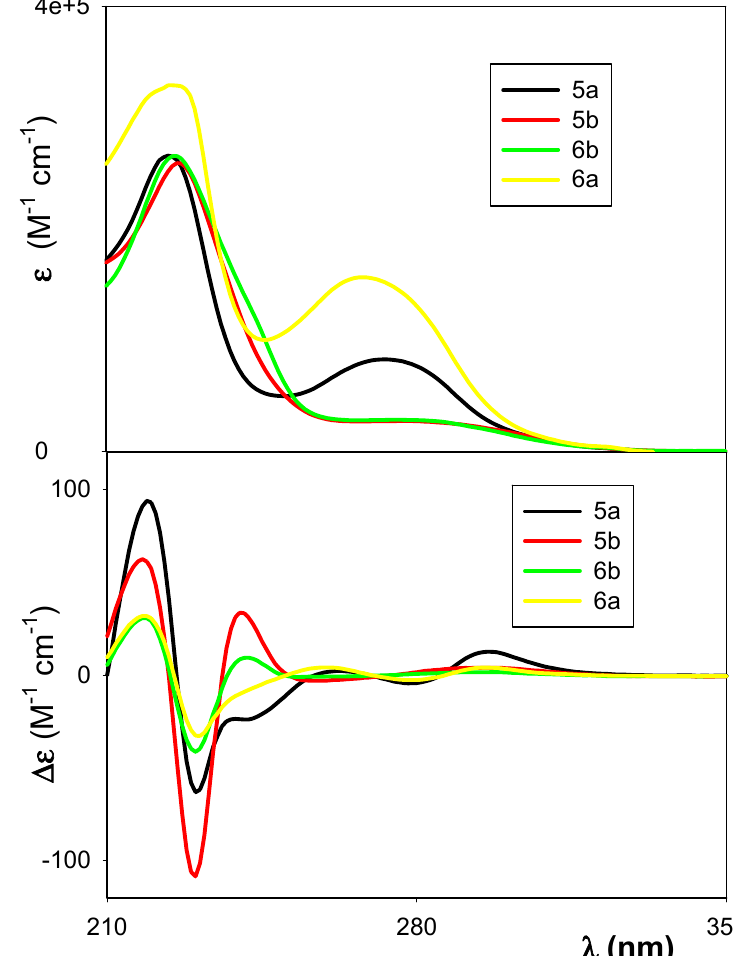
λ (nm) Figure 2. UV ( top ) and circular dichroism (CD) ( bottom ) spectra of macrocycles 5 and 6 . Concentrations: 10 − 5 M for UV and 2.2–2.6 10 − 6 M for CD spectroscopy in MeCN.